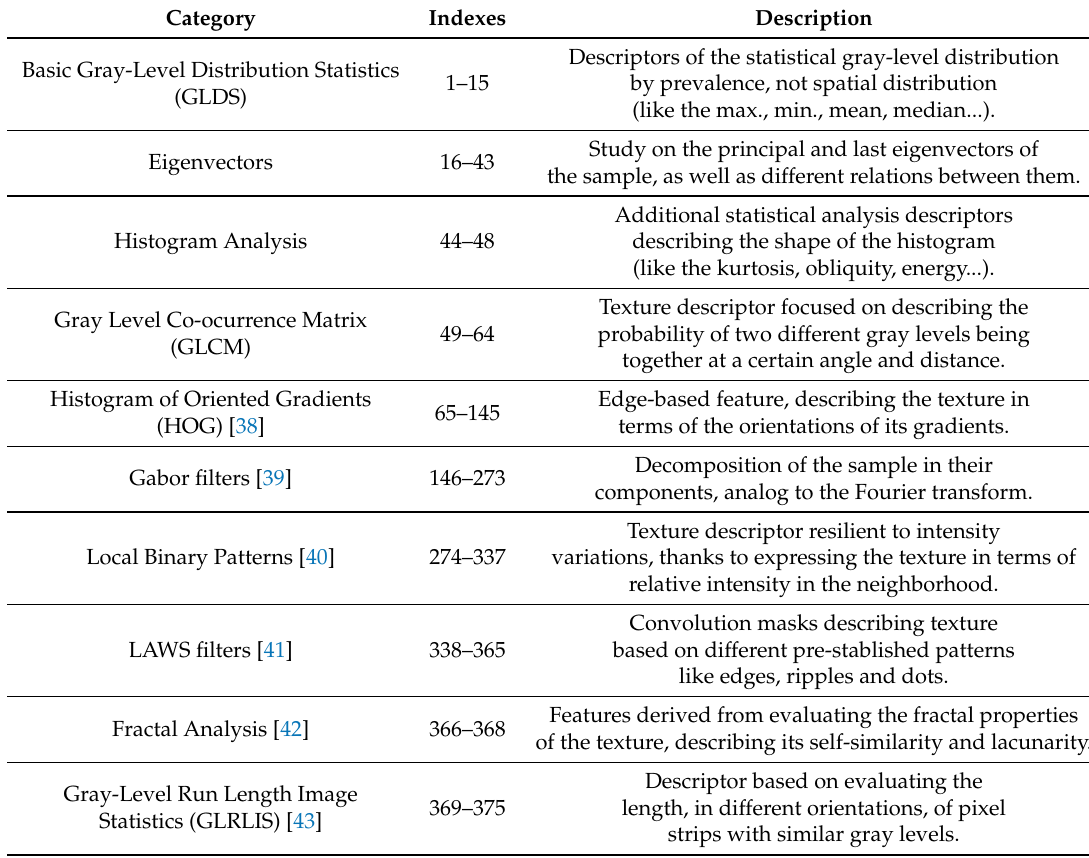
Table 1. Summary of the extracted feature